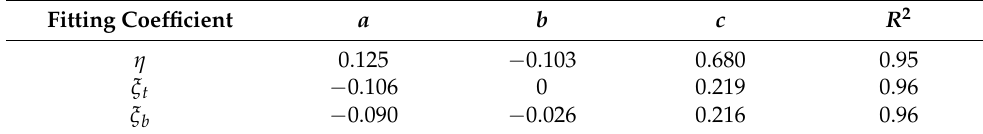
Table 1. Fitting parameters for calculation method of stiffness reduction.